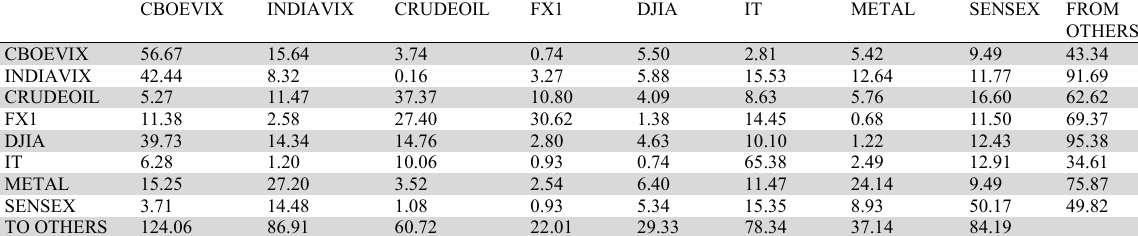
Diebold-Yilmaz Spillover at D6 Scale